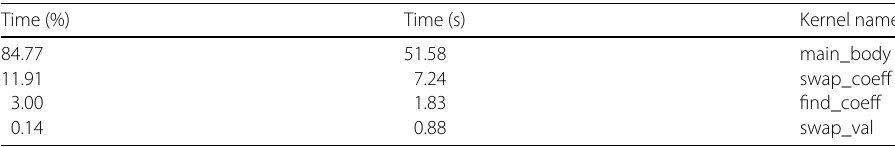
Table 12 Performance of the main kernels for Example 5 Time (%) Time